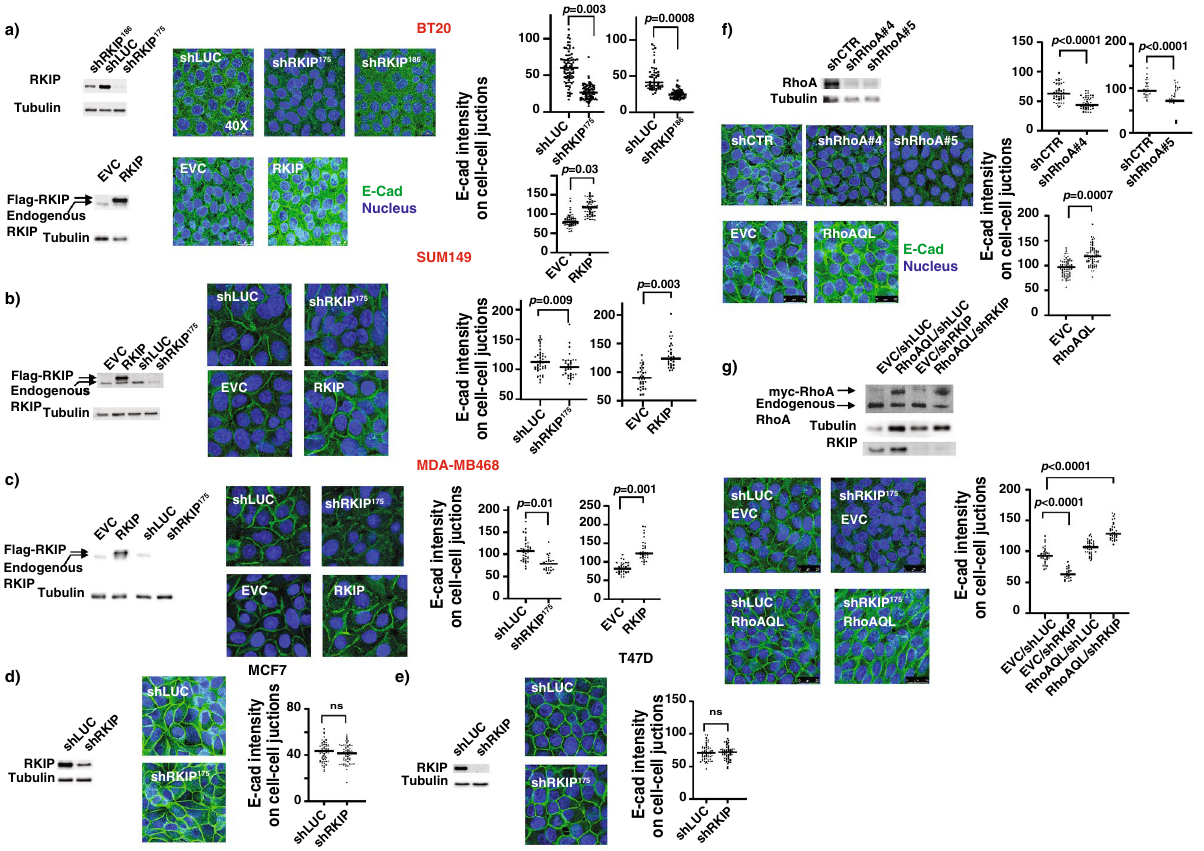
Figure 2. RKIP functions through downstream RhoA to promote E-cadherin (E-cad) localization to cell-to- cell junctions. ( a ) (Left) Representative western blots of lysates prepared from control knockdown (shLUC), two different RKIP knockdowns (shRKIP 175/186 ), empty vector control, or RKIP expressing BT20 cells. (Middle) Representative images of immunofluorescent staining with E-cad Ab and DRAQ5 of the same set of BT20 cells shown in the left panel. (Right) E-cad intensity quantification on cell–cell junctions of immunofluorescent images shown in the middle panel using MetaMorph analysis software. ( b ) (Left) Representative western blots of lysates prepared from control knockdown (shLUC), RKIP knockdowns (shRKIP 175 ), empty vector control (EVC), or RKIP expressing SUM149 cells. (Middle) Representative images of immunofluorescent staining with E-cad Ab and DRAQ5 of the same set of SUM149 cells shown in the left panel. (Right) E-cad intensity quantification on cell–cell junctions of immunofluorescent images shown in the middle panel using MetaMorph analysis software. ( c ) (Left) Representative western blots of lysates prepared from control knockdown (shLUC), RKIP knockdowns (shRKIP 175 ), empty vector control (EVC), or RKIP expressing MDA-MB468 cells. (Middle) Representative images of immunofluorescent staining with E-cad Ab and DRAQ5 (Nucleus) of the same set of MDA-MB468 cells shown in the left panel. (Right) E-cad intensity quantification on cell–cell junctions of immunofluorescent images shown in the middle panel using MetaMorph analysis software. ( d ) (Left) Representative western blots of lysates prepared from control knockdown (shLUC), or RKIP knockdowns (shRKIP 175 ) MCF7 cells. (Middle) Representative images of immunofluorescent staining with E-cad Ab and DRAQ5 of the same set of MCF7cells shown in the left panel. (Right) E-cad intensity quantification on cell–cell junctions of immunofluorescent images shown in the middle panel using MetaMorph analysis software. ( e ) (Left) Representative western blots of lysates prepared from control knockdown (shLUC), or RKIP knockdowns (shRKIP 175 ) T47D cells. (Middle) Representative images of immunofluorescent staining with E-cad Ab and DRAQ5 of the same set of T47D cells shown in the left panel. (Right) E-cad intensity quantification on cell–cell junctions of immunofluorescent images shown in the middle panel using MetaMorph analysis software. ( f ) (Left, top) Representative western blots of lysates prepared from control knockdown (shCTR), two different RhoA knockdowns (shRhoA#4/#5), empty vector control, or RhoAQL expressing BT20 cells. (Left, bottom) Representative images of immunofluorescent staining with E-cad Ab and DRAQ5 of the same set of BT20 cells shown in the left top panel. (Right) E-cad intensity quantification on cell–cell junctions of immunofluorescent images shown in the left bottom panels using MetaMorph analysis software. ( g ) (Left, top) Representative western blots of lysates prepared from BT20 cells with different combinations of controls, RKIP knockdown (shRKIP 175 ) and RhoAQL expression as indicated. (Left, bottom) Representative images of immunofluorescent staining with E-cad Ab and DRAQ5 of the same set of BT20 cells shown in the left top panel. (Right) E-cad intensity quantification on cell–cell junctions of immunofluorescent images shown in the left bottom panels using MetaMorph analysis software. Unpaired Student’s t-test (two-tailed) was used for all analyses with p < 0.05 considered significant. ns not